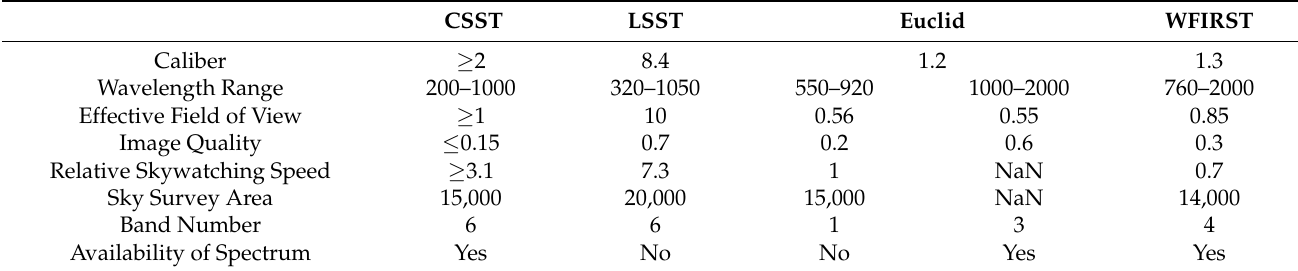
Table 1. Specifications of LSST, WFIRST, Euclid, and the suggested wide and deep survey on board the CSST [27].